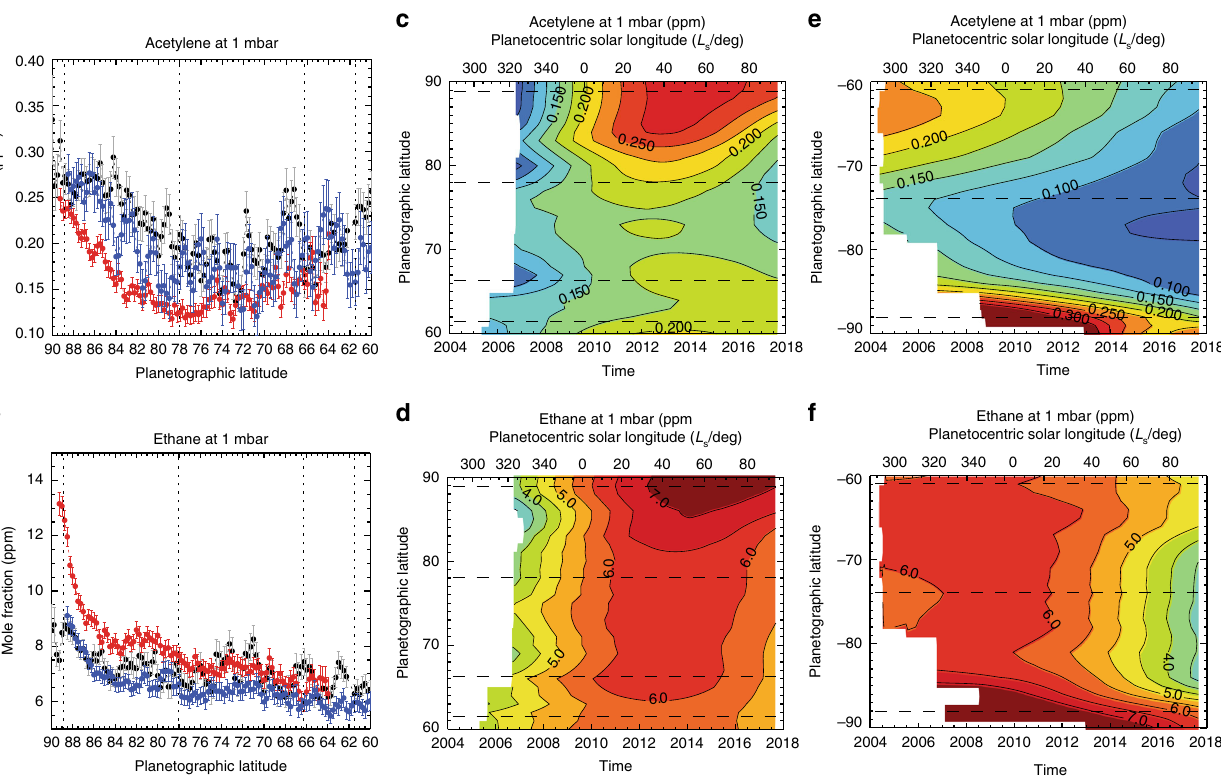
Fig. 9 Temporal evolution of polar ethane and acetylene. Latitudinal distributions of a acetylene and b ethane at 1 mbar as derived from spectra on August 17, 2013 (black, REGMAP 196 – 001), June 25, 2014 (blue, REGMAP 205 – 001) and February 12, 2017 (red, REGMAP 261 – 003). These results come from scaling of the hydrocarbon pro fi les derived for the north pole from the 0.5-cm − 1 resolution observations, at the same time as retrieving the temperature pro fi les in Fig. 8. Uncertainties on these retrieved scale factors are shown for each data point. The four contour plots show the spline-interpolated results for c north polar acetylene, d north polar ethane, e south polar acetylene and f south polar ethane from the low-resolution time series in Fig. 4. Dotted/ dashed lines show the locations of prograde jet peaks 9 in all six